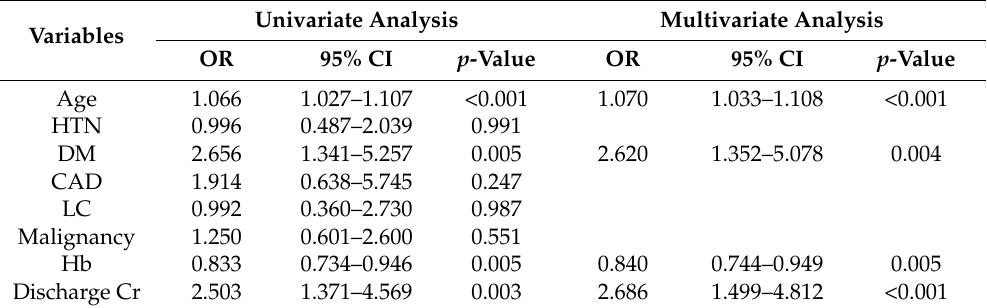
Table 3. Multivariate logistic regression of factors associated with the occurrence of CKD after one